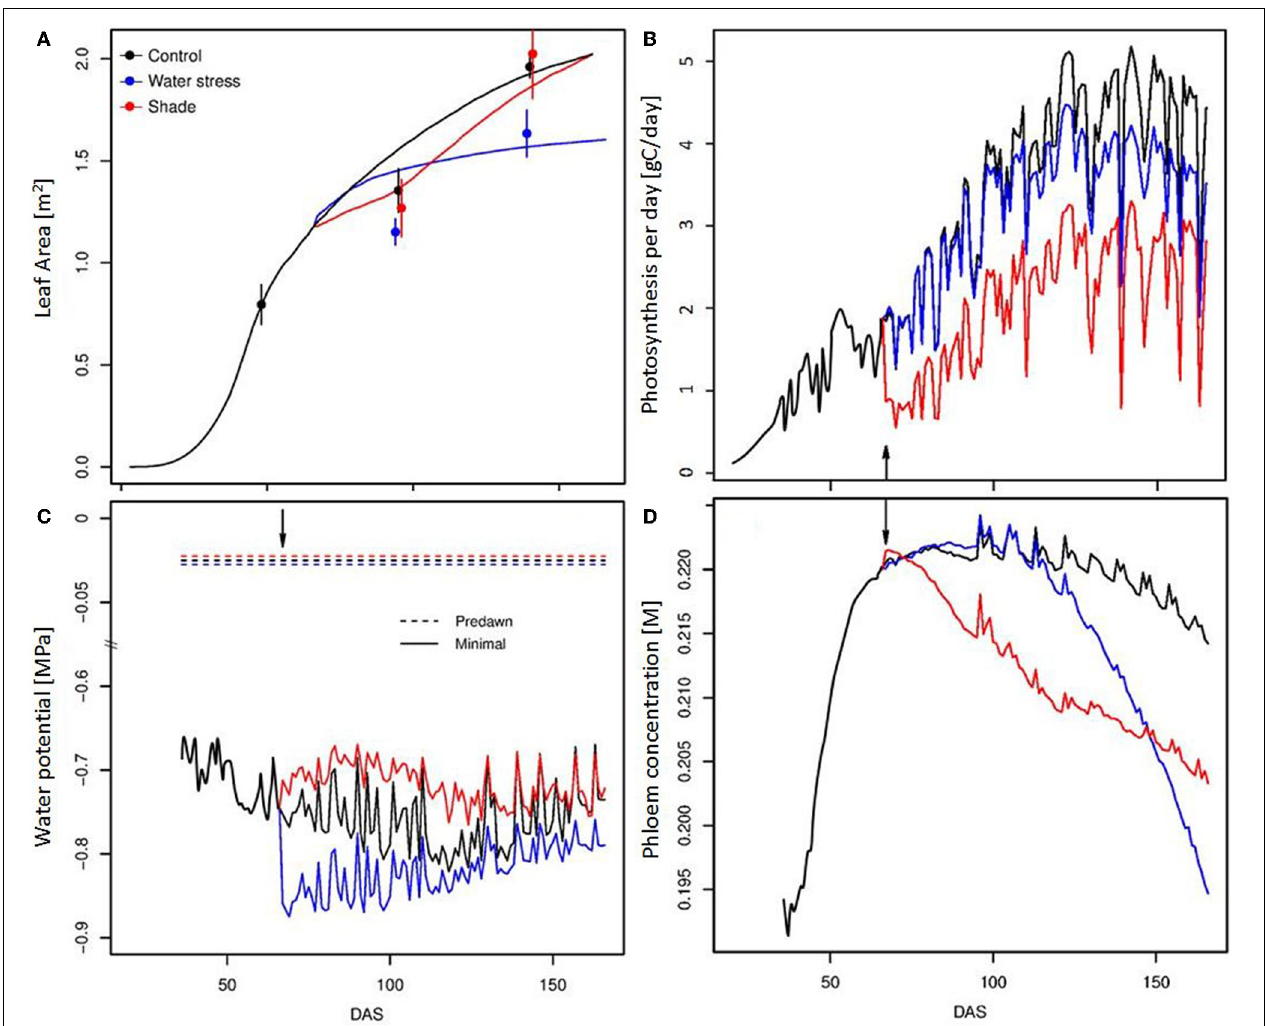
FIGURE 3 | Temporal evolution (DAS, Days After Sowing) of the leaf surface (A), of the daily plant photosynthesis (B), predawn and minimal mean stem water potentials (C) and mean daily phloem concentration